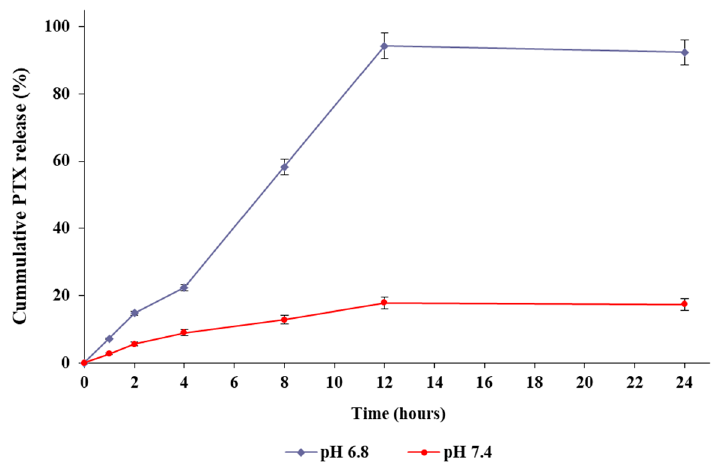
Figure 7. In vitro PTX release profiles from the CLA-coated PTX-SPIONs at pH 6.8 and pH 7.4. Data from experiments are presented as the mean ± SD, n = 3.